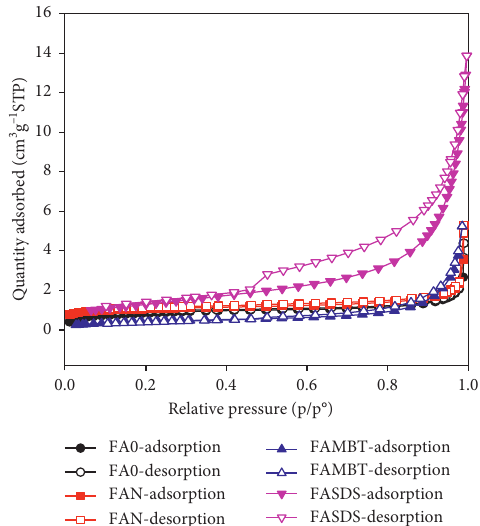
Figure 6: Nitrogen adsorption-desorption curves of FA0, FAN, and modified FAN